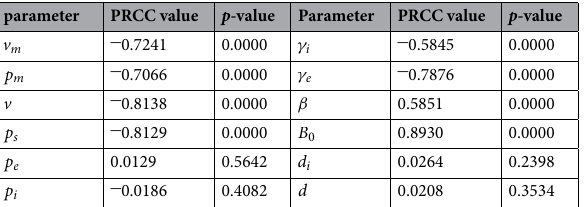
Table 5. PRCC values and p -values of each parameter in the compartment E ( t ).